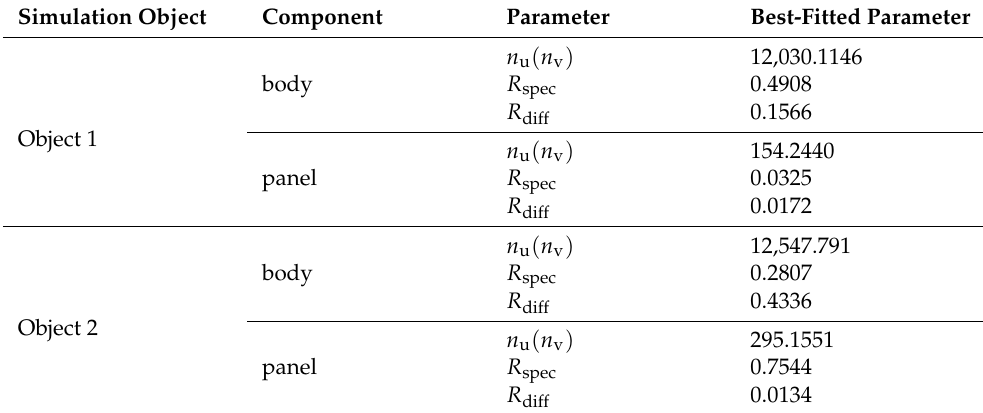
Table 3. The best-fitted parameters of the simulation objects.